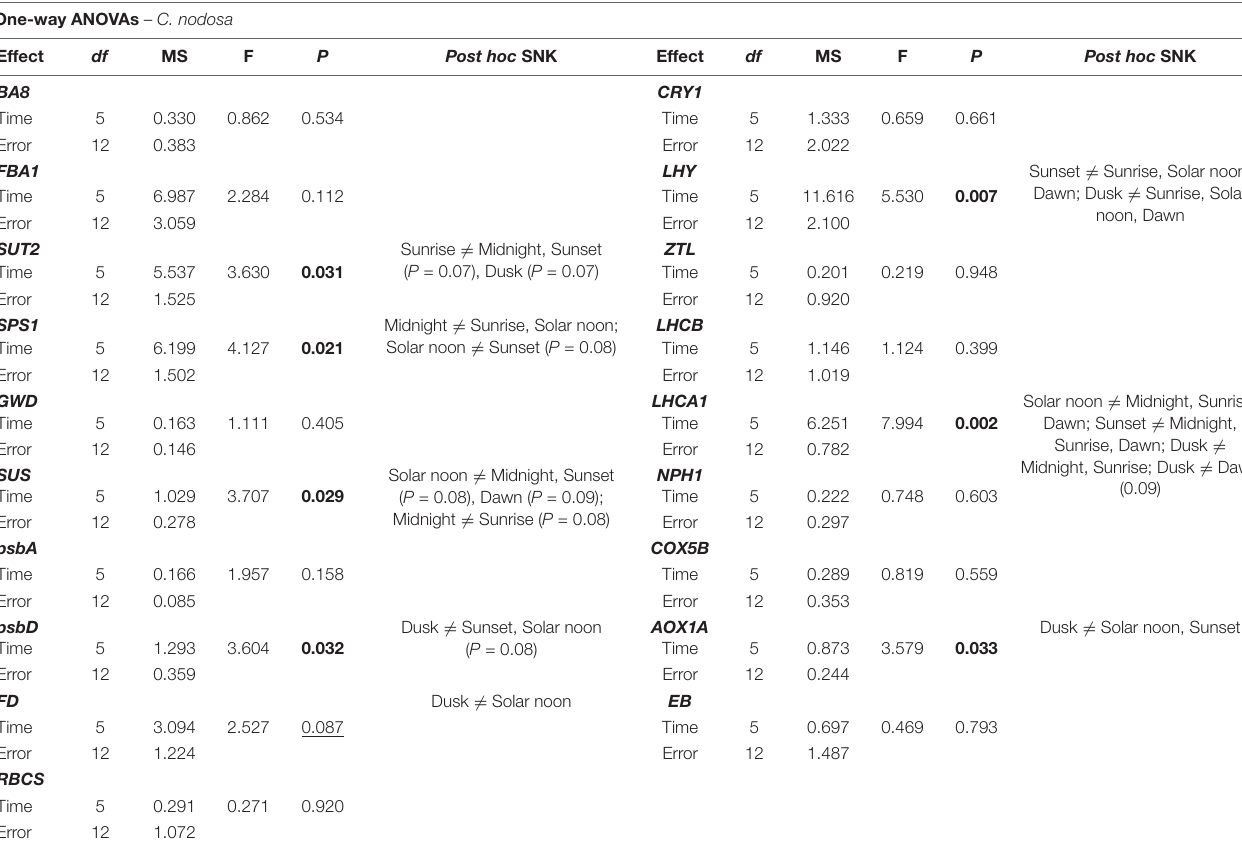
TABLE 3 | Results of one-way ANOVAs based on – (cid:49) CT data of individual Genes of Interests in Cymodocea nodosa . One-way ANOVAs – C.